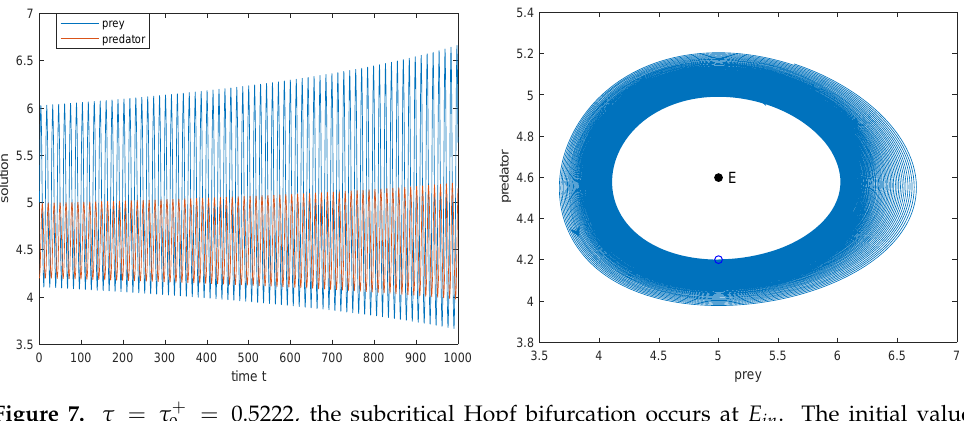
in . The initial value: